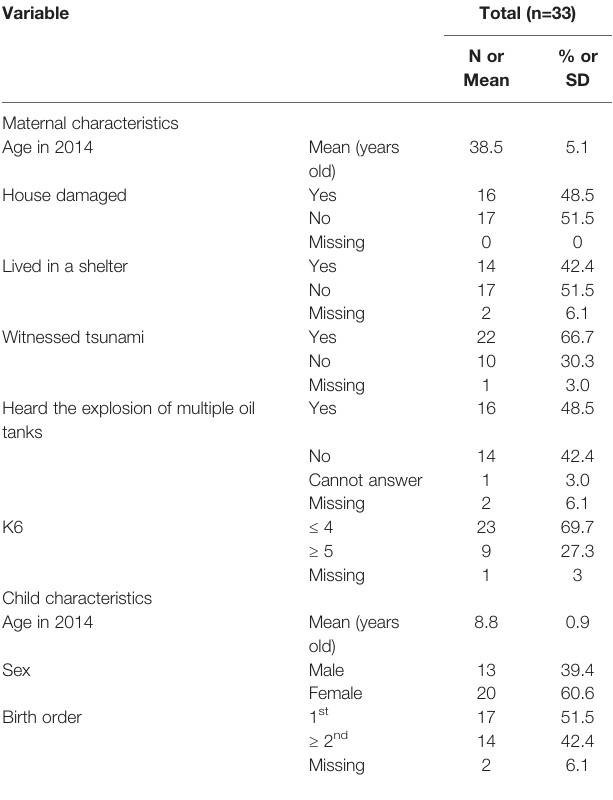
N or % or Mean SD old)